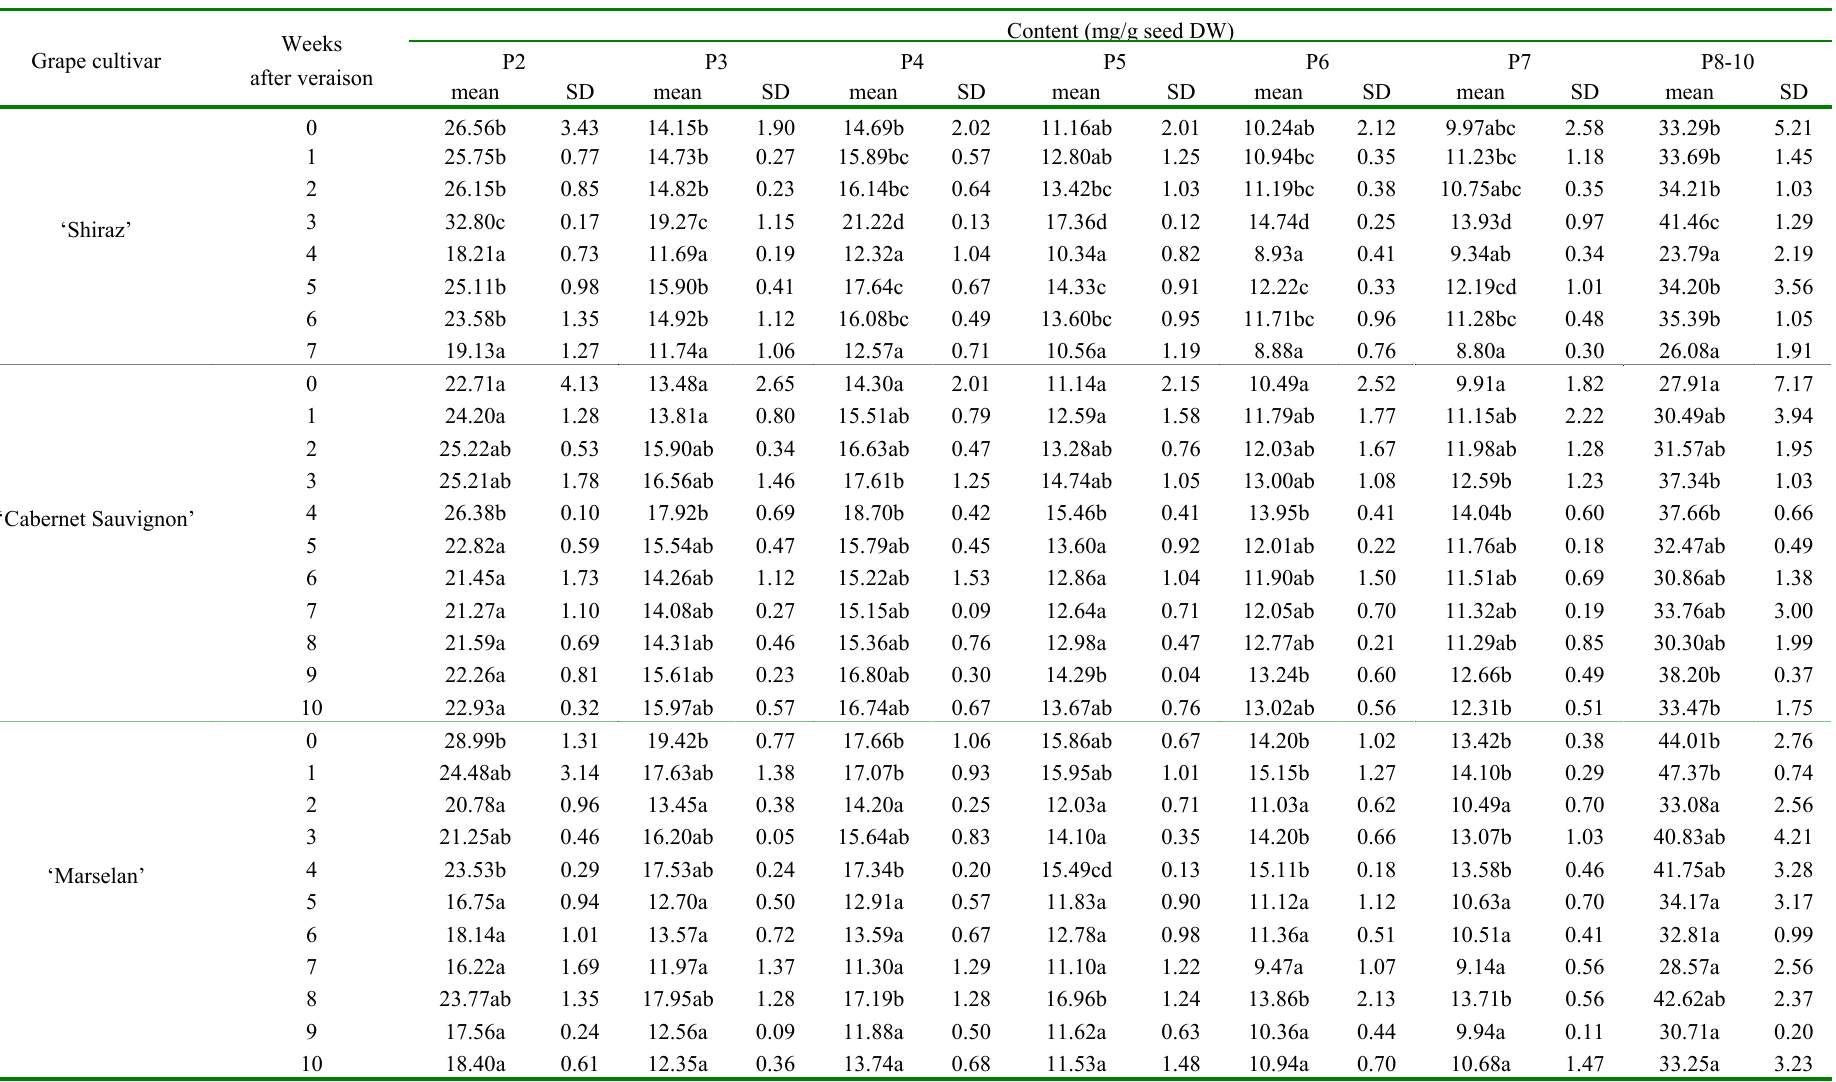
Table 2. Content of individual oligomers in ‘Shiraz’, ‘Cabernet Sauvignon’, ‘Marselan’ grape seeds after veraison. Grape